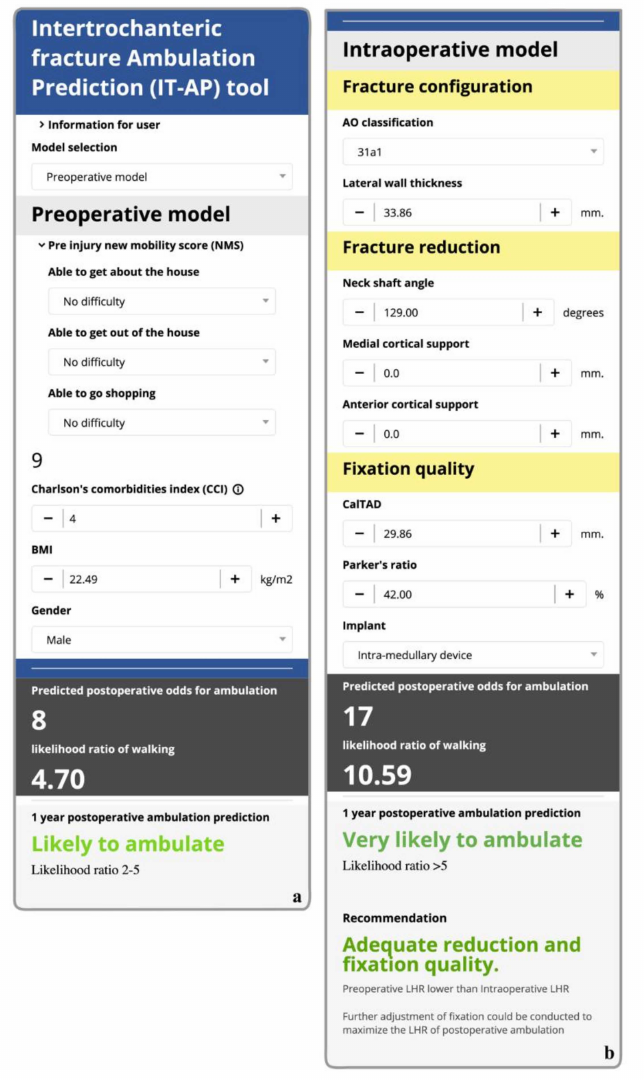
Figure 4. An interface of the Intertrochanteric fracture ambulation prediction (IT-AP) tool with an example information ( a ) preoperative model ( b ) intraoperative